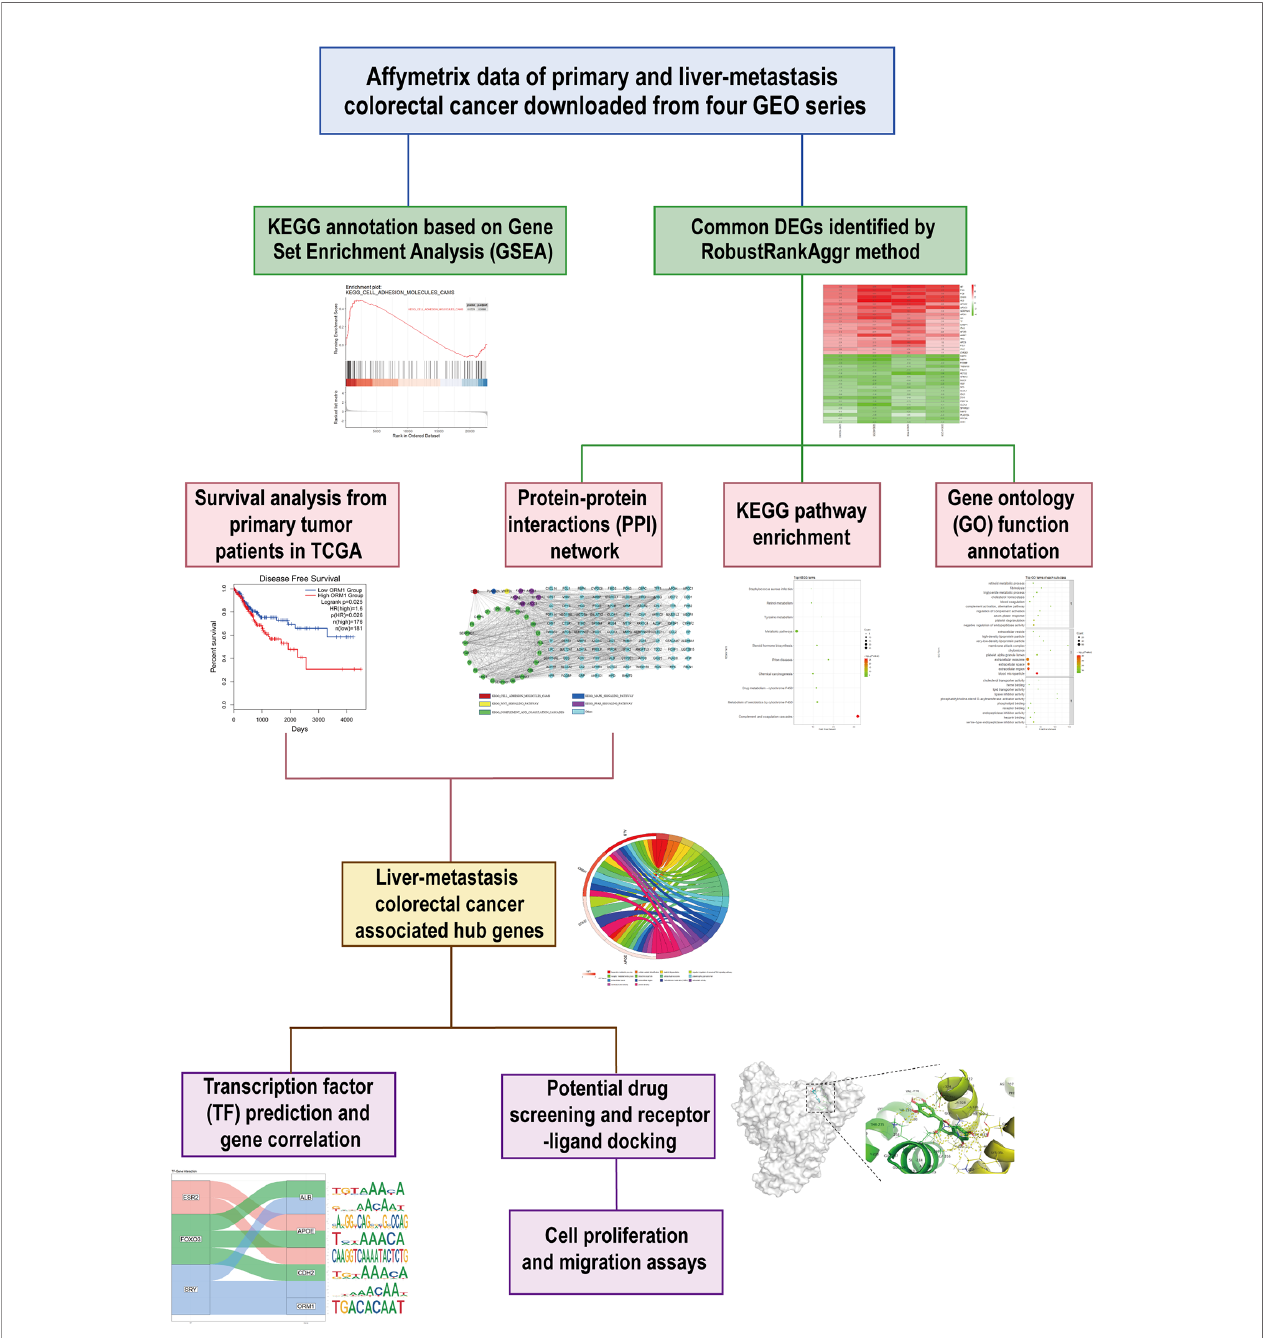
FIGURE 1 | Schematic work fl ow to present the design of this